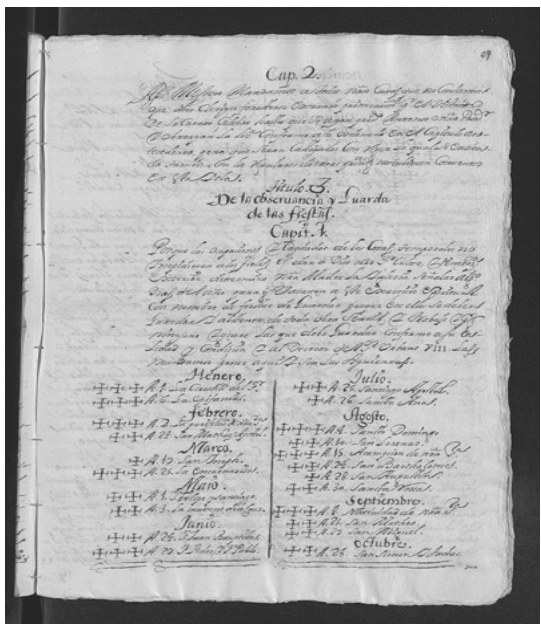
Figure 14. Liturgical calendar with feast days in Hispaniola as of 1683, “Titulo 3. De la Observancia y guarda de las fiestas”, in Proemio Yquicion de la Sancta Synodo , Folio VI, Number 247 to 301 (1683 to 1699), Santo Domingo 93, Archivo General de Indias. Used with permission from Ministerio